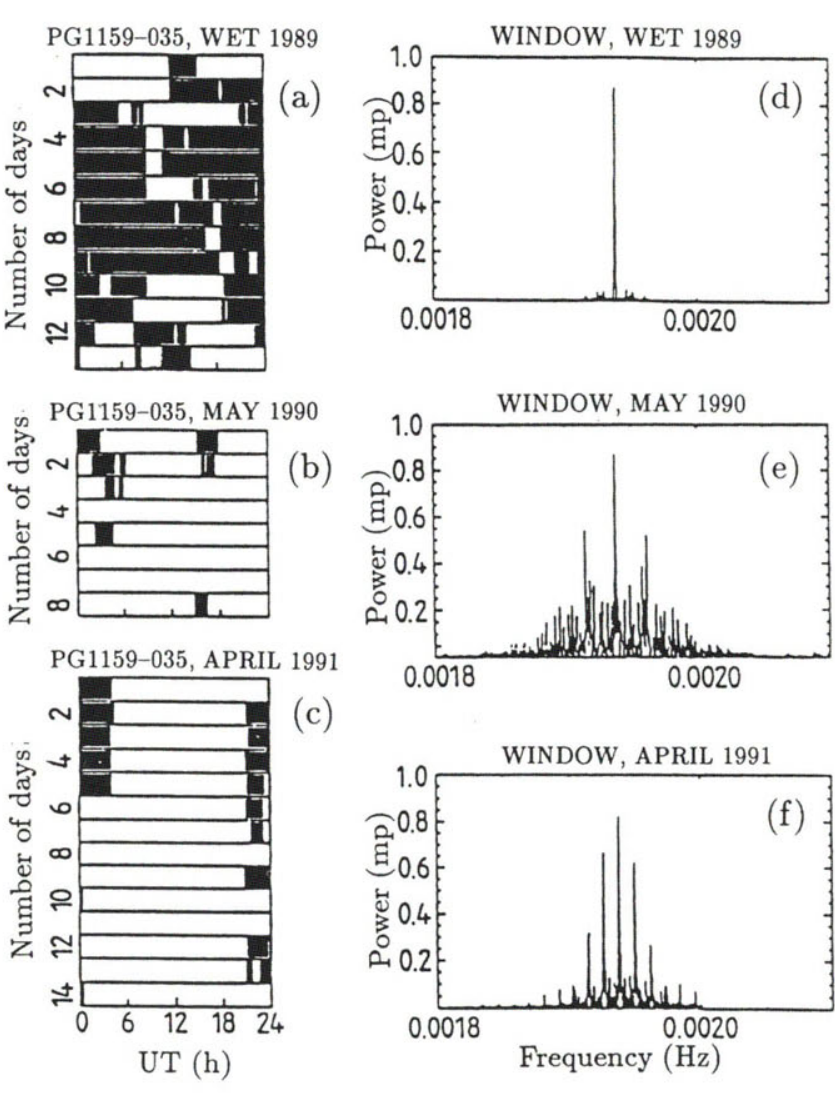
Fig. 1. The coverage and windows for the three sets of observations of PG 1159-035. The coverage is shown on the left-hand side with one panel per day. On the right-hand side there are the window functions for the data sets. Note the difference between the single site data set (f) and the data set of May 1990